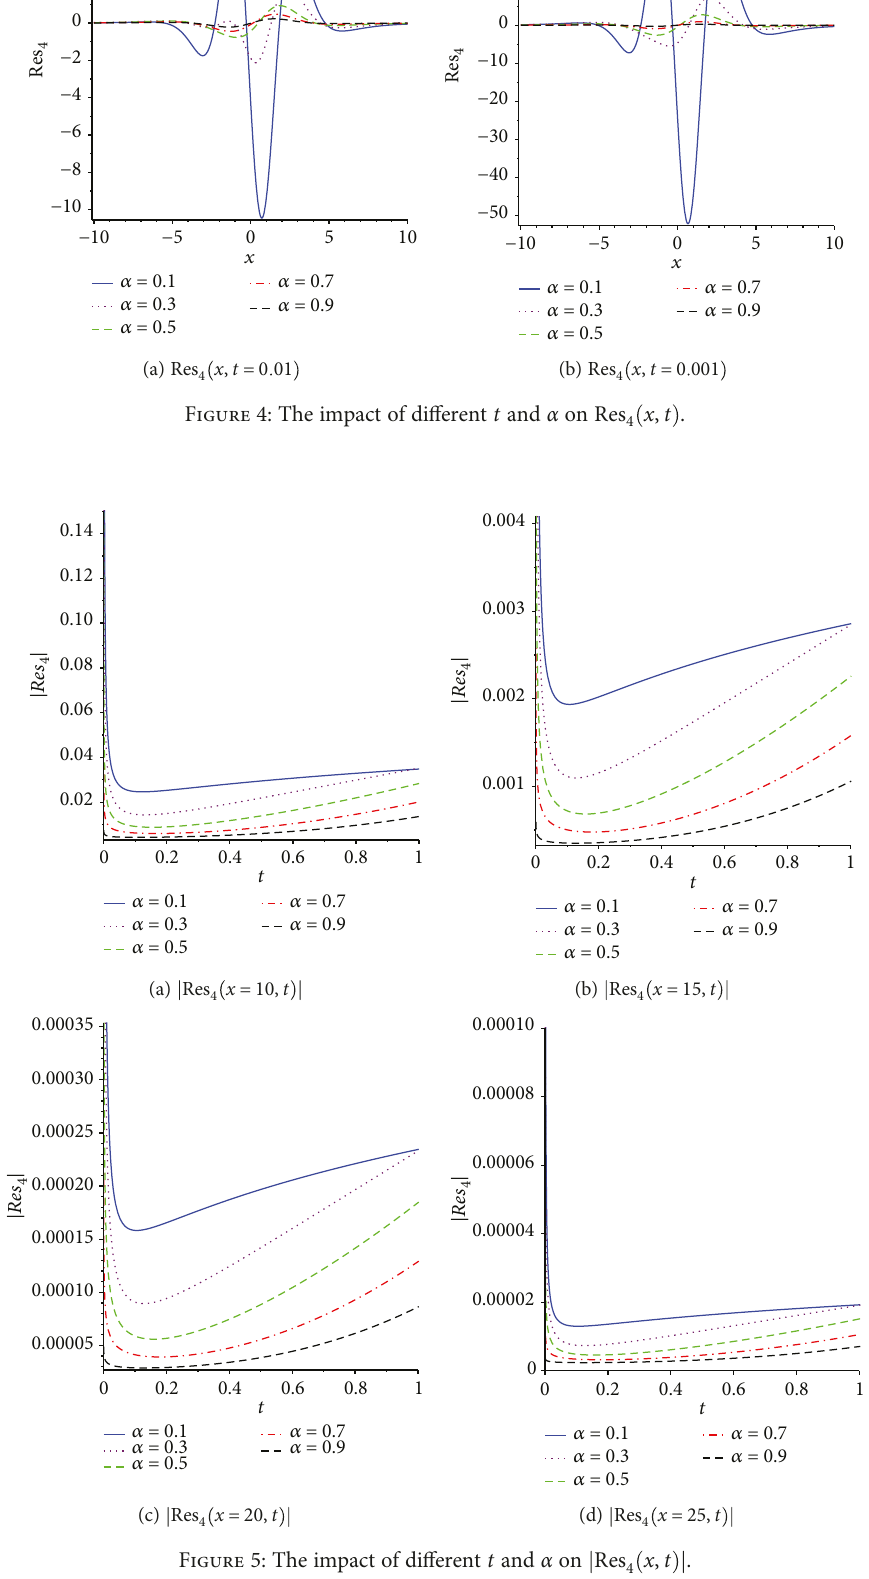
Figure 5: The impact of di ff erent t and α on Res